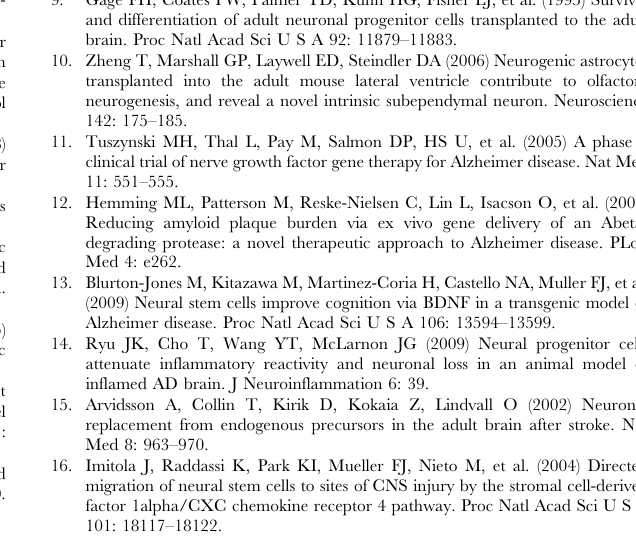
Figure S5 Geometric analyses of short-term NSC en- graftments. 3D reconstruction of serial sections shows engraft- ments form a sheet-like spread in the corpus callosum (A) and a globular spread in the thalamus (B). To distinguish these differences numerically, the travel distance of NSCs in the transverse plane ( x ) was divided by the travel distance in the vertical plane ( y ), yielding an anisotropic value, A. A is 7.3 6 larger in the corpus callosum compared to the thalamus (C). Similar